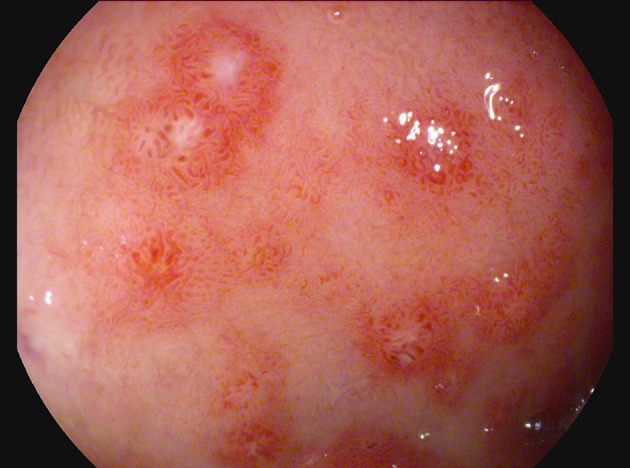
Detail of duodenal lesions (PENTAX i-scan imaging).